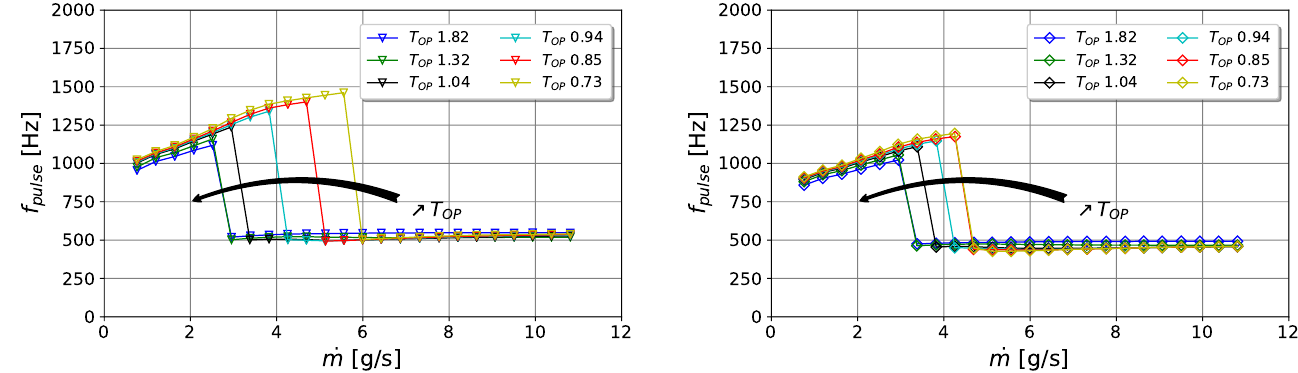
Figure 17. Variation of throttling ratio using the reference geometry, a constant feedback loop diameter. D + = 0.91 and feedback loop length of L + = 1.5 × 10 2 ( left ) respectively L + = 1.8 × 10 2 ( right